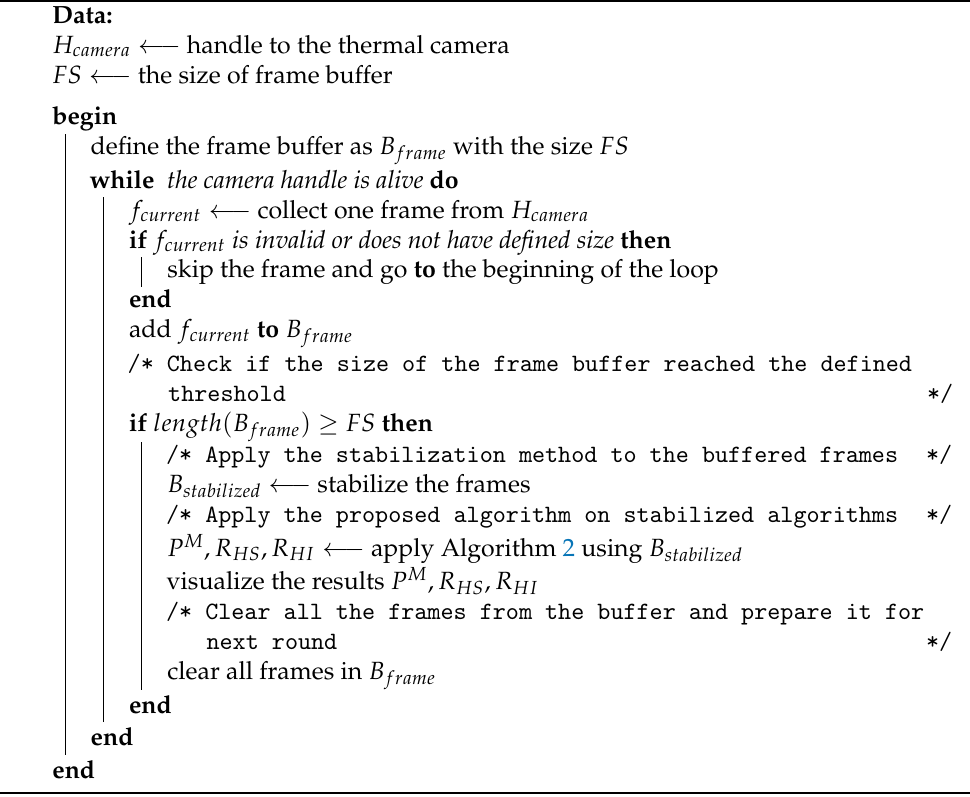
Algorithm 1: The proposed steps for drone-enabled gas leak detection and visually- enhancement of gas